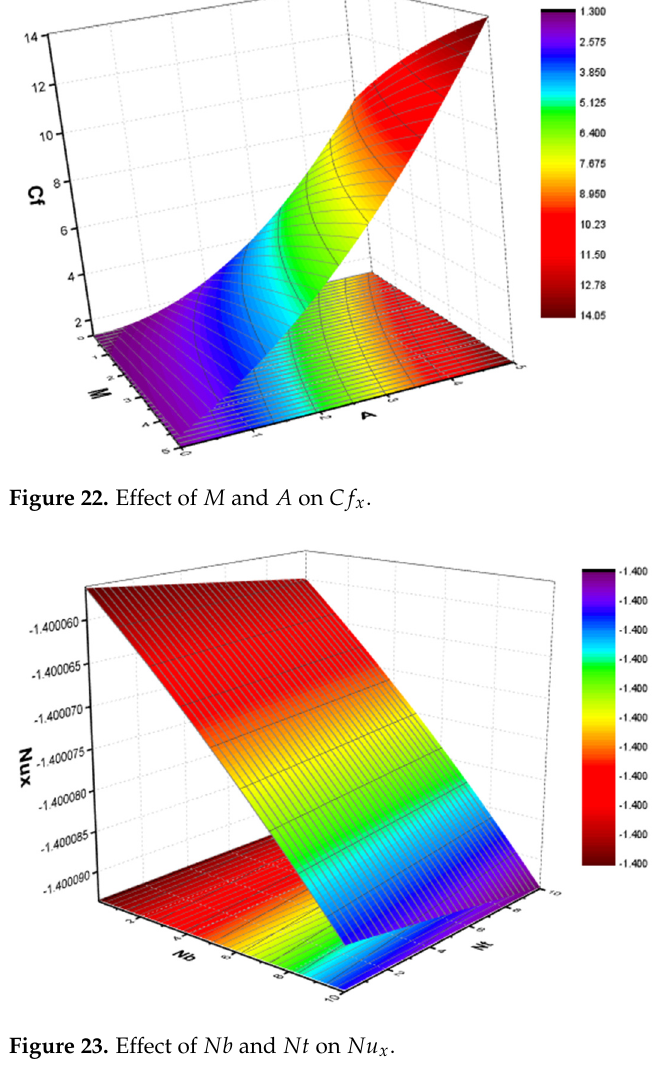
Figure 23. Effect of Nb and Nt on Nu x .